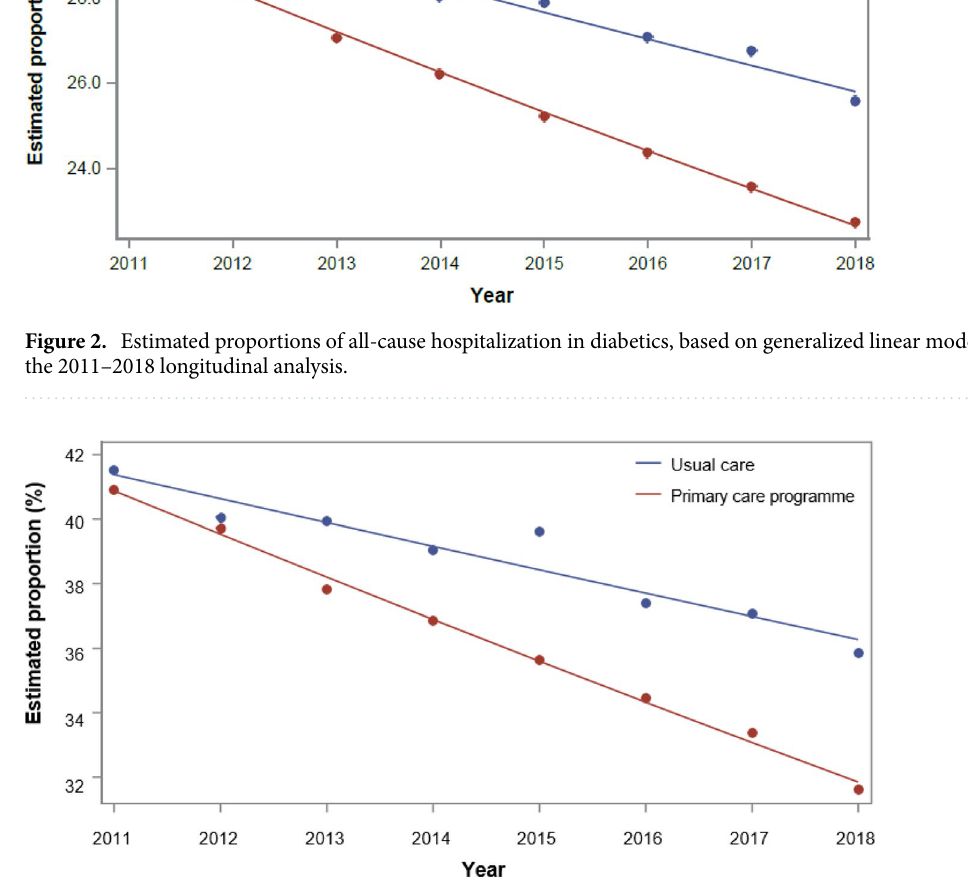
Figure 3. Estimated proportions of all-cause hospitalization in CHF patients, based on generalized linear models of the longitudinal analysis from 2011 to 2018.